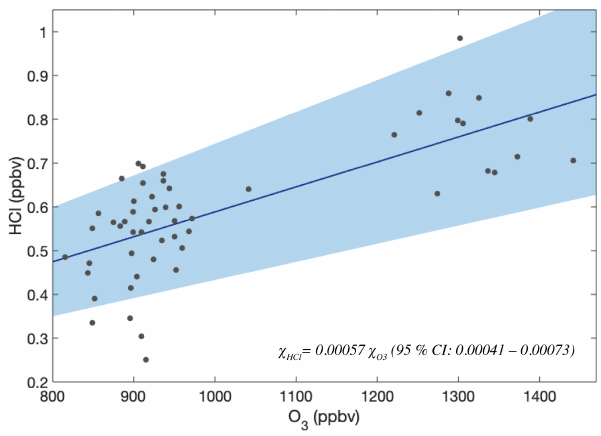
Figure 17. Plot of HUSCE O 3 vs. HCl observations between 65– 80hPa (grey circles). The line corresponds to the slope calculated from the HUSCE observations, and the shaded area represents the 95% confidence interval range for the regression